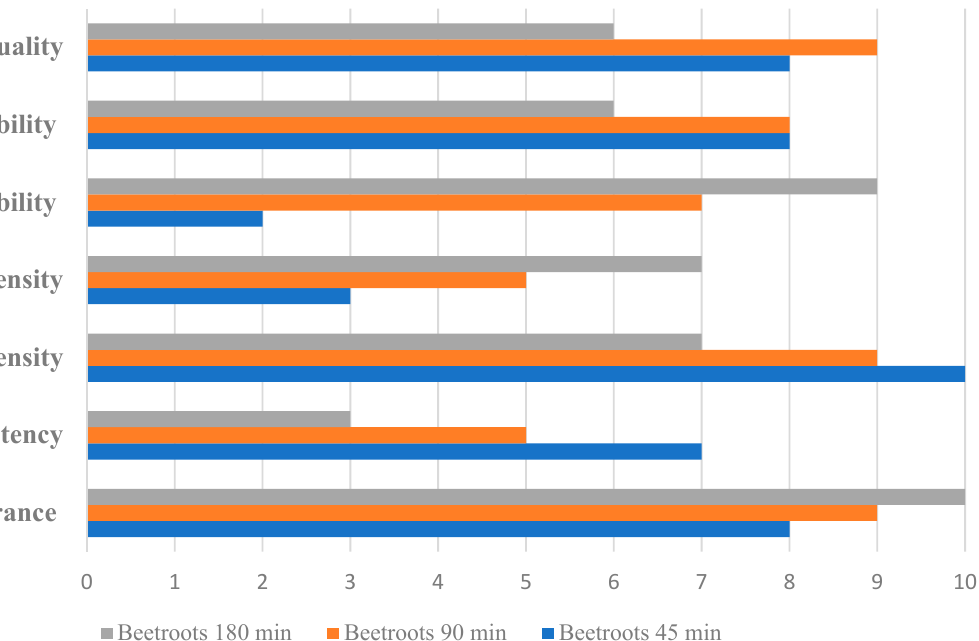
Figure 3. Results of sensory evaluation of sous-vide processed beetroots.